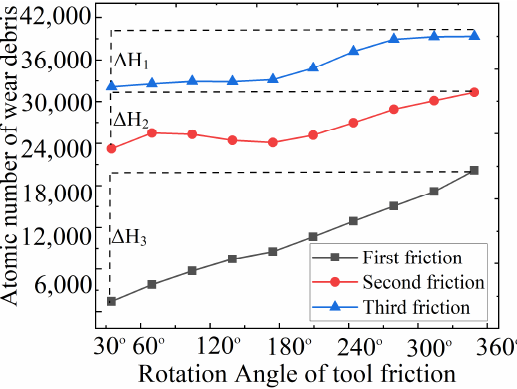
Figure 8. The number of atoms of debris expelled after three frictions.